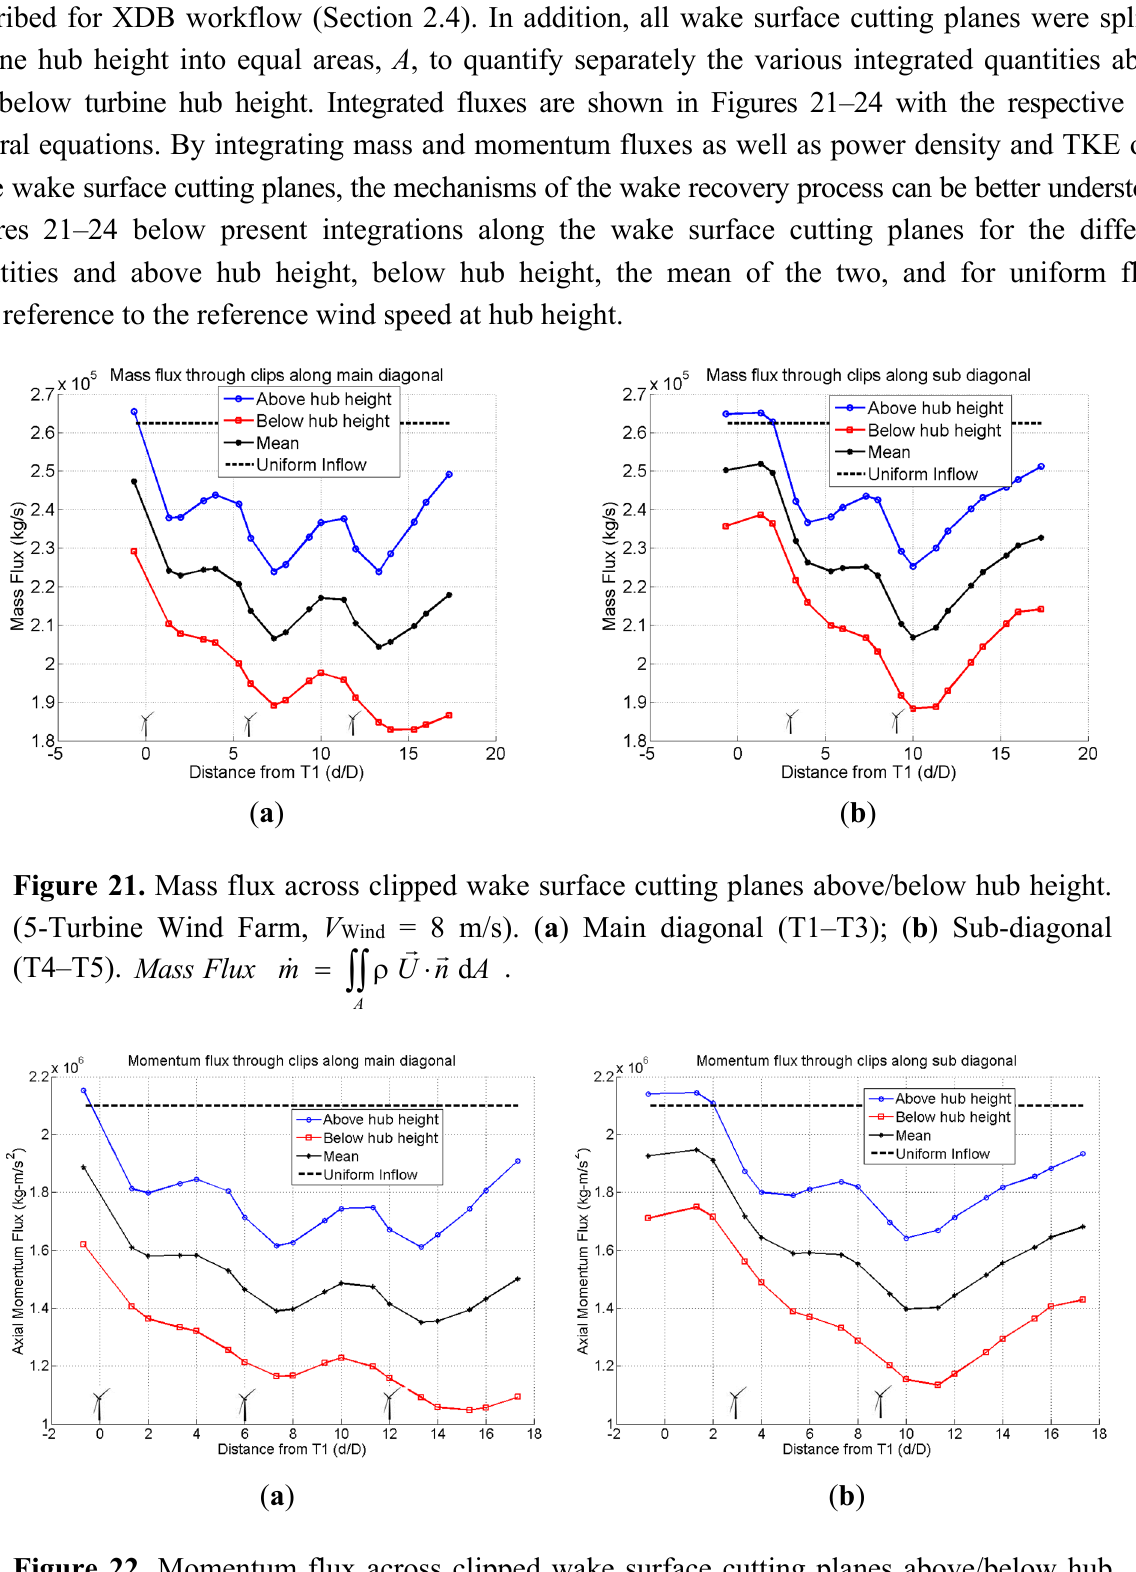
Figure 22. Momentum flux across clipped wake surface cutting planes above/below hub